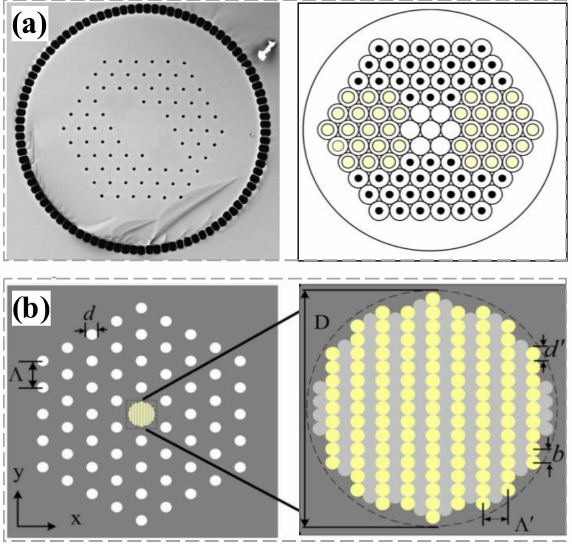
Figure 6. Fiber cross-sections and design structure. ( a ) A single-polarization single transverse mode large mode area PCF developed at the University of Jena, Germany, 2005 [52]; ( b ) A new highly birefringent large-mode area PCF proposed by Ming-Yang Chen at Jiangsu University, 2007